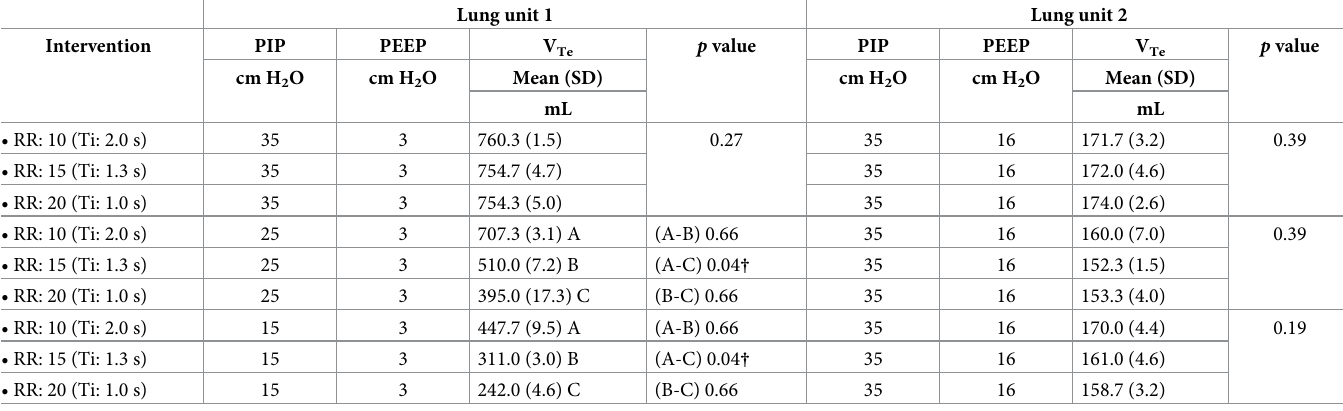
Table 4. Resulting variations of VT e (mL) in paired lung units after a sole modification of the respiratory rate in the ventilator using a variable inspiratory time of 2 seconds, while applying a flow restriction of 0, 10 and 20 cm H 2 O in lung unit 1, which resulted in a PIP of 35, 25 and 15 cm H 2 O, respectively. Lung unit 1 Lung unit 2 Intervention PIP PEEP V